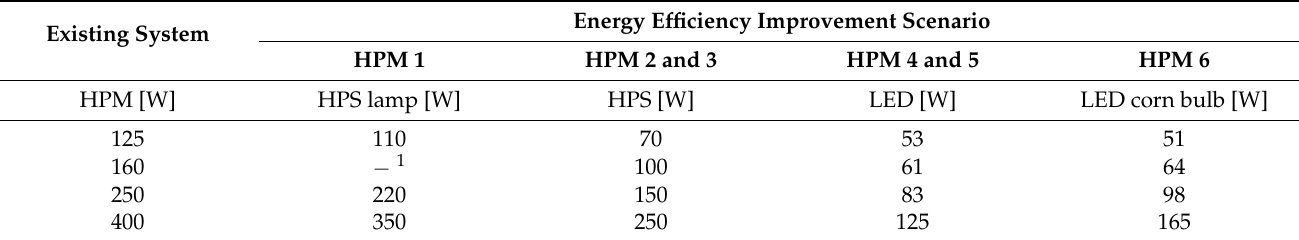
Table 2. Equivalent lighting source for different HPM lamp/luminaire replacement scenarios. Existing